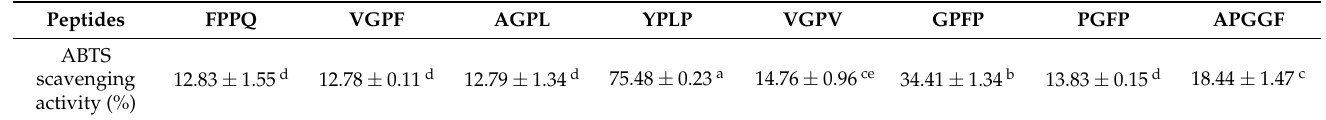
Table 4. ABTS radical scavenging activity of synthetic peptides at a concentration of 2 mg/mL.